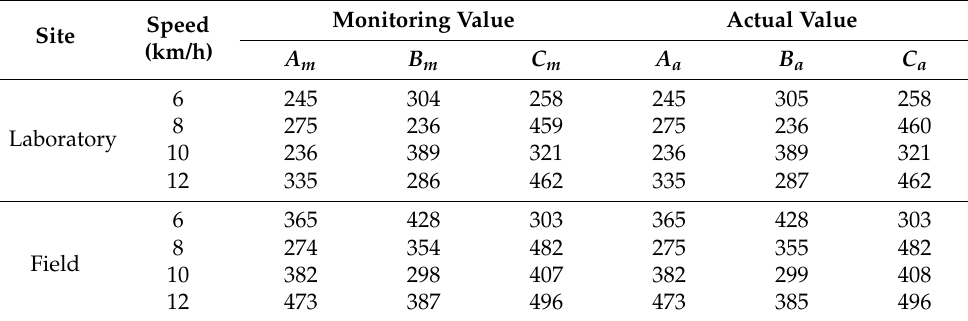
Table 3. Statistical results of monitoring data and actual data.